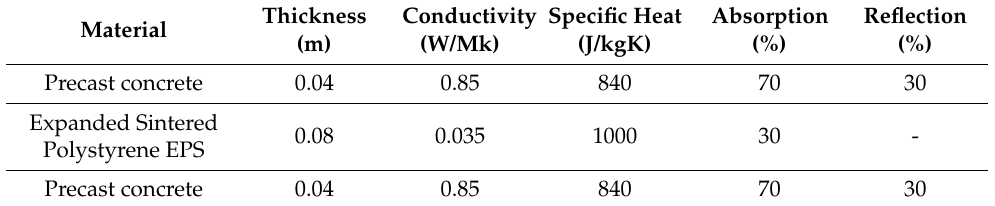
Table 4. Stratigraphy settings for the precast concrete panels used in the buildings’ external walls.